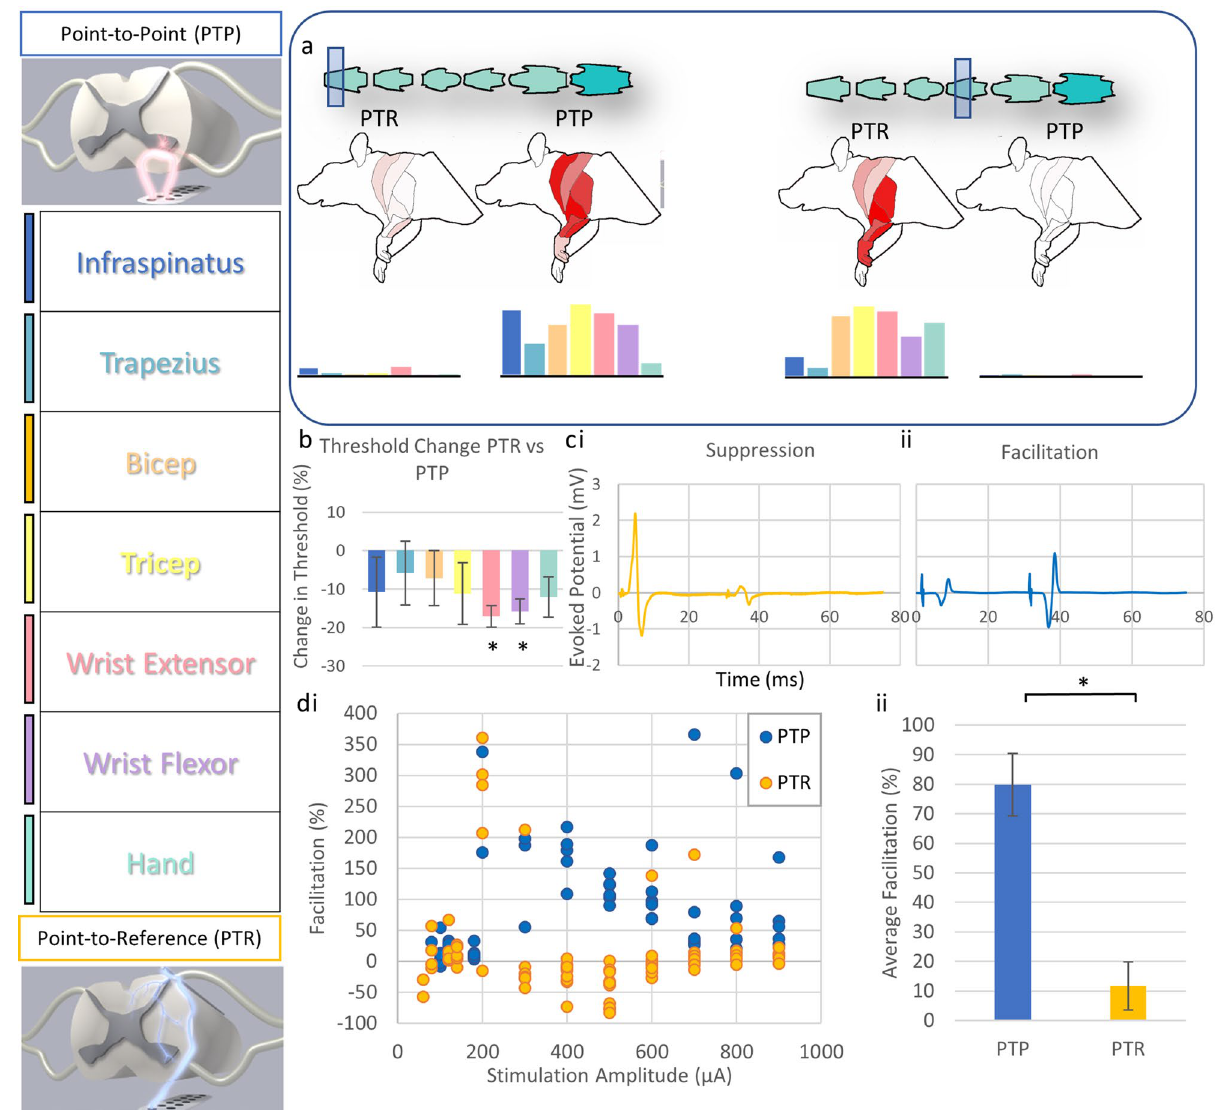
Figure 6. Modes of stimulation. ( a ) Examining the evoked muscle responses at each position along the spinal cord with both point-to-point (PTP) and point-to-reference (PTR) stimulation revealed positions where each mode induced distinct responses within the spinal cord. Each measurement demonstrates muscle activity at 400 µA constant current stimulation. The shaded box indicates the spinal level of stimulation and the intensity of red in the rat forelimb diagram indicates the level of activation of a given muscle group by relative muscle activity. This information is displayed below each diagram as a bar graph displaying muscle activity at each location normalized as a fraction from 0 to 1 where 1 is the maximal evoked response observed for each muscle at any stimulated position. ( b ) Thresholds were also affected by PTR vs PTP stimulation. For instance, at the C5/6 level, the thresholds of the wrist flexor and extensor were 15.7 and 17.1% lower respectively when stimulated at the same position in PTR vs PTP mode and there was a trend to lower overall thresholds in PTR mode. ( c ) Following a spinal stimulation doublet with a 30 ms interstimulation interval, we observed changes in the second evoked potential where the second amplitude was (i) lowered indicating signal suppression or (ii) raised indicating spinal facilitation. ( d ) (i) We analyzed the relative facilitation/suppression observed in both modes at various stimulation intensities and observed, (ii) PTP mode resulted in a greater degree of spinal wires can produce sustained improvement in voluntary upper limb reaching and grasping even after termination of therapeutic stimulation 14 . Nevertheless, parenchymal implantation of electrode wires requires invasive surgery and carries the risk of infection, tissue damage, and scarring that could worsen over time. Here, we developed a completely wireless, ventral spinal approach to allow for more flexible targeting of motor associated spinal circuitry, while maintain- ing safety and translational potential of an epidural approach. We posit our VSS stimulator can operate in two modes: (1) point-to-point, a more selective stimulation strategy that likely targets motor neurons and their inputs